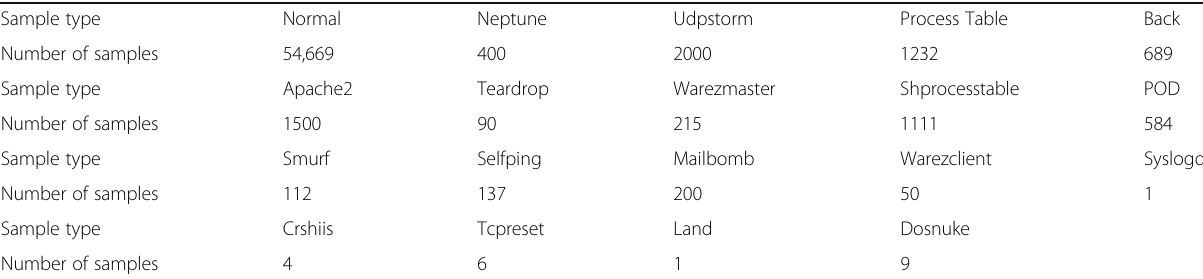
Table 2 Detect sample type distribution